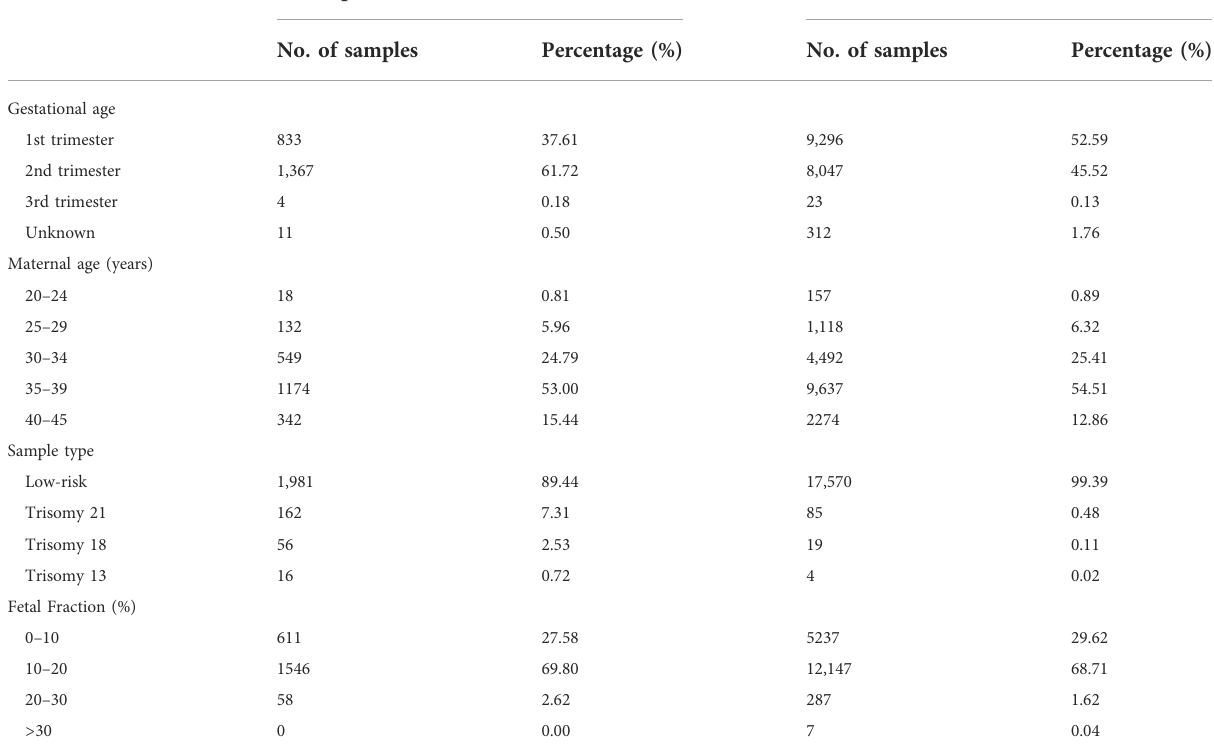
TABLE 2 Composition of the development and clinical